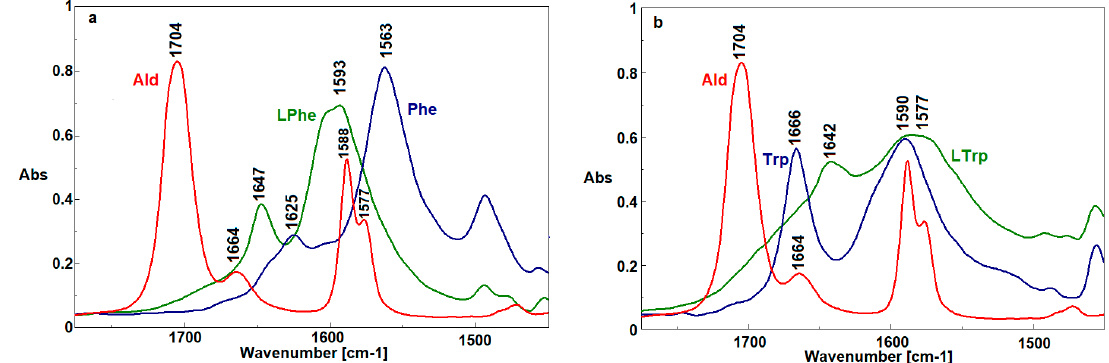
Figure 3. FTIR spectra of HPhe, 2-C-pyridine aldehyde, and phenylenealanine ( a ), and HTrp, 2-C-pyridine aldehyde and tryptophane ( b ).